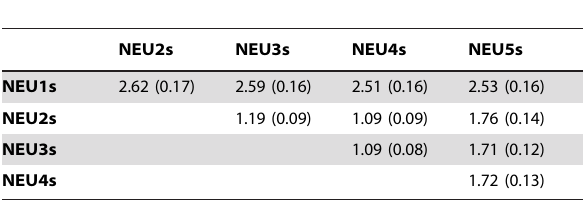
Table 2. Estimates of evolutionary divergence over sequence pairs between